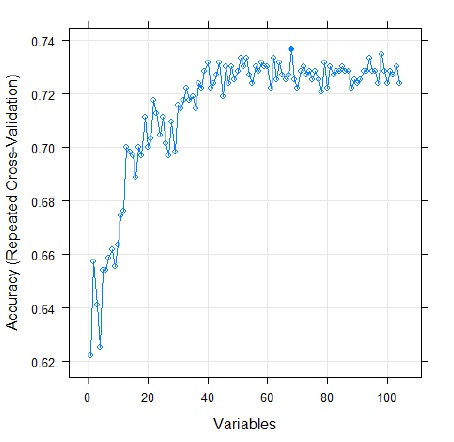
Figure 4. An example of random forest recursive feature elimination with automatic tuning of the number of features selected (10-fold cross-validation with 3